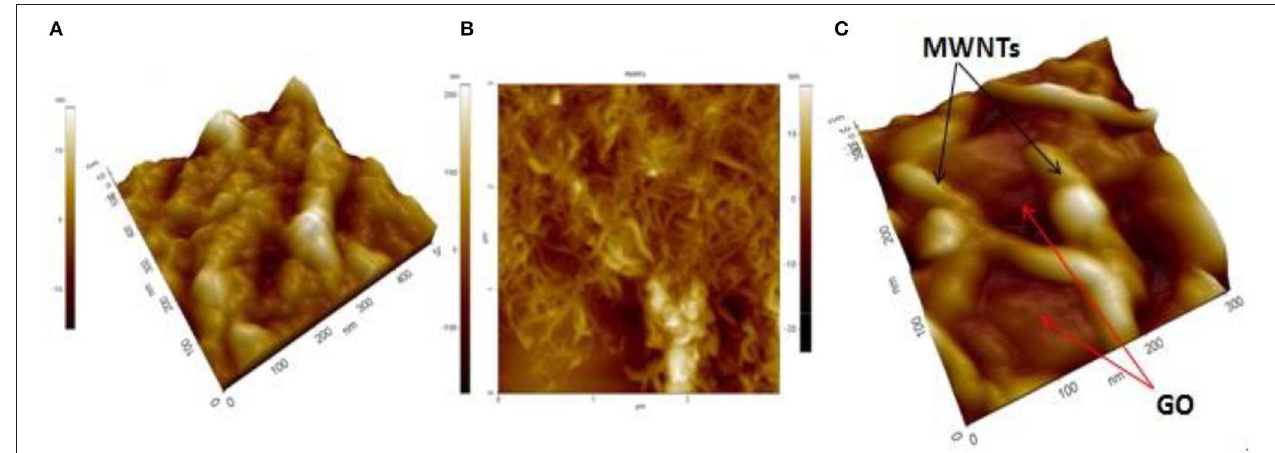
FIGURE 4 | Non-contact mode AFM images of: (A) exfoliated GO, (B) functionalize MWNTs, and (C) GO–MWNTs hybrid deposit by drop casting on Si/SiO 2 substrates.